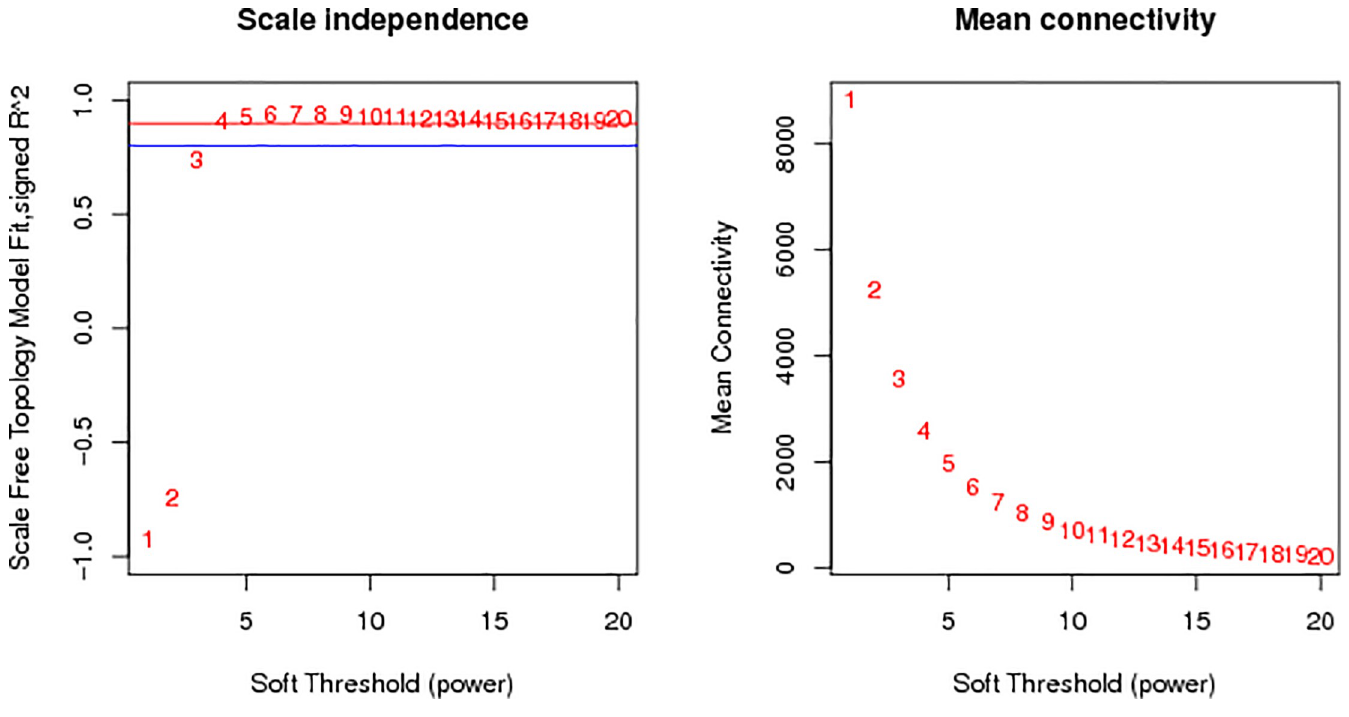
Fig 2. Power value